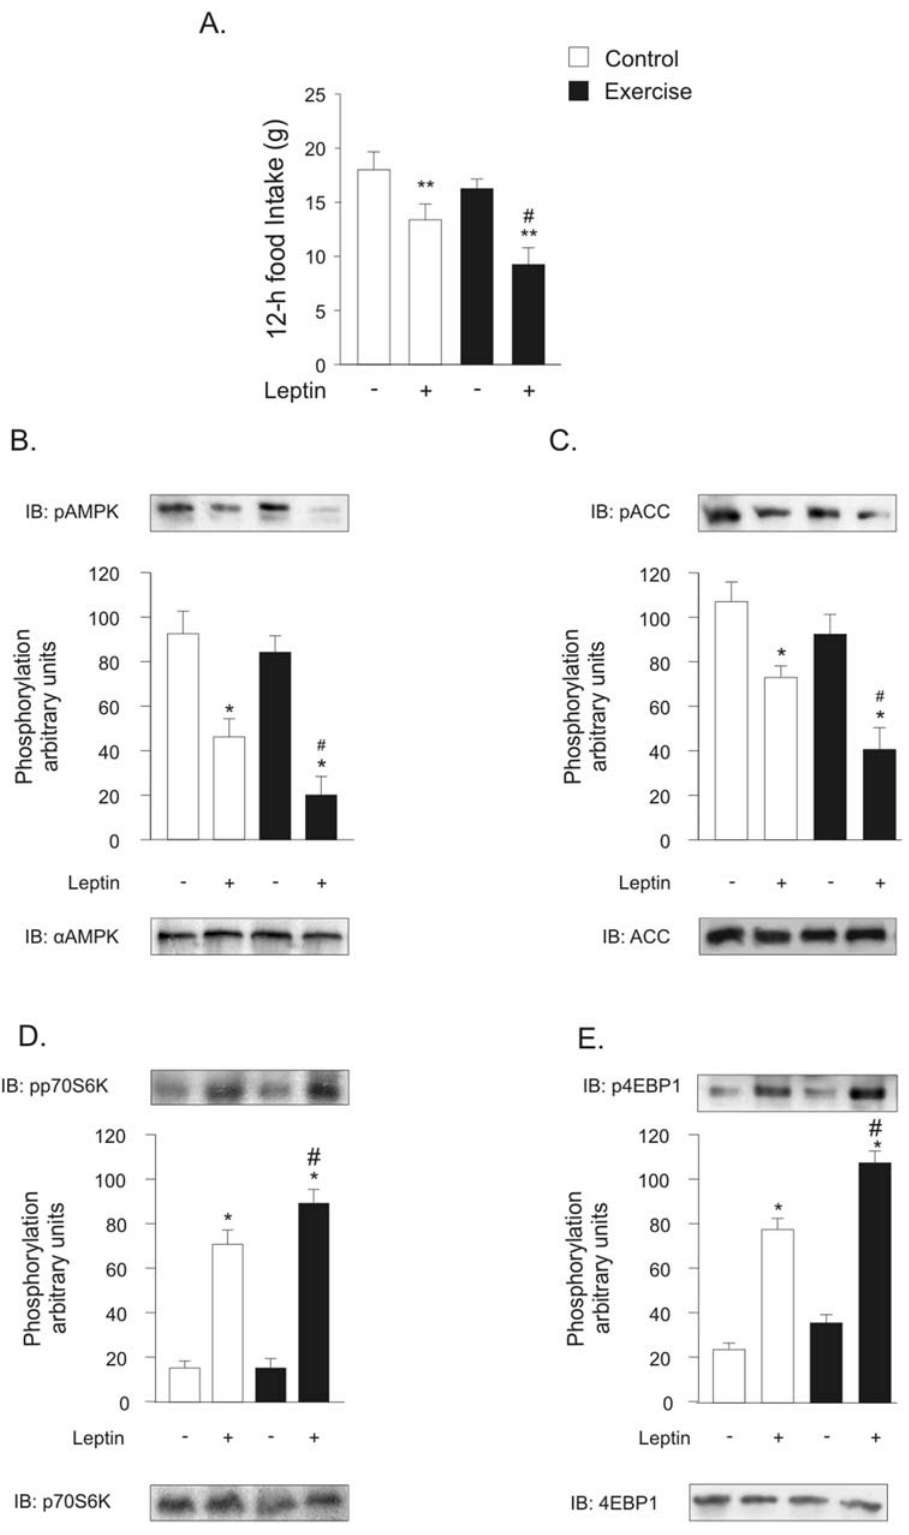
Figure 5. Leptin effects on 12-h cumulative food intake and AMPK/mTOR signaling, in the hypothalami of control and exercised rats. (a) Leptin (10 2 6 M) was administered in control and exercised rats. Animals were immediately exposed to food for a 12-hour period ( n =12–15 animals per group). (b, c, d, e) Representative Western blots of five independent experiments showing hypothalamic lysates from Wistar rats. Phospho-AMPK thr172 , threonine-phosphorylated AMPK and total AMPK (b); phospho-ACC ser79 , serine phosphorylated ACC and total ACC (c); phospho- p70S6Kinase thr389 , threonine phosphorylated p70S6Kinase and total p70S6K (d); phospho-4EBP1 thr70 , threonine phosphorylated 4EBP1 and total 4EBP1 (e). Data are the means 6 SEM. * p , 0.05, ** p , 0.01, vs. control group; # p , 0.05, ## p , 0.01 vs. leptin-stimulated control group.